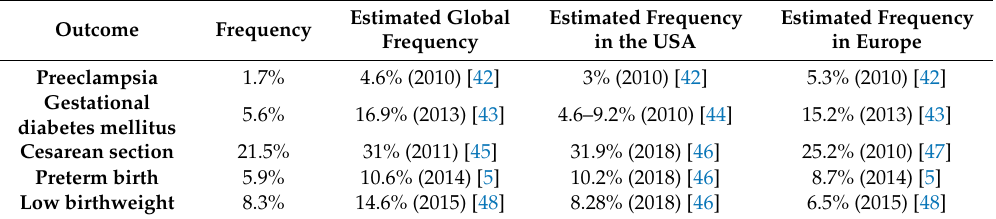
Table 3. Frequency of pregnancy and perinatal adverse outcomes compared to global and regional frequencies.